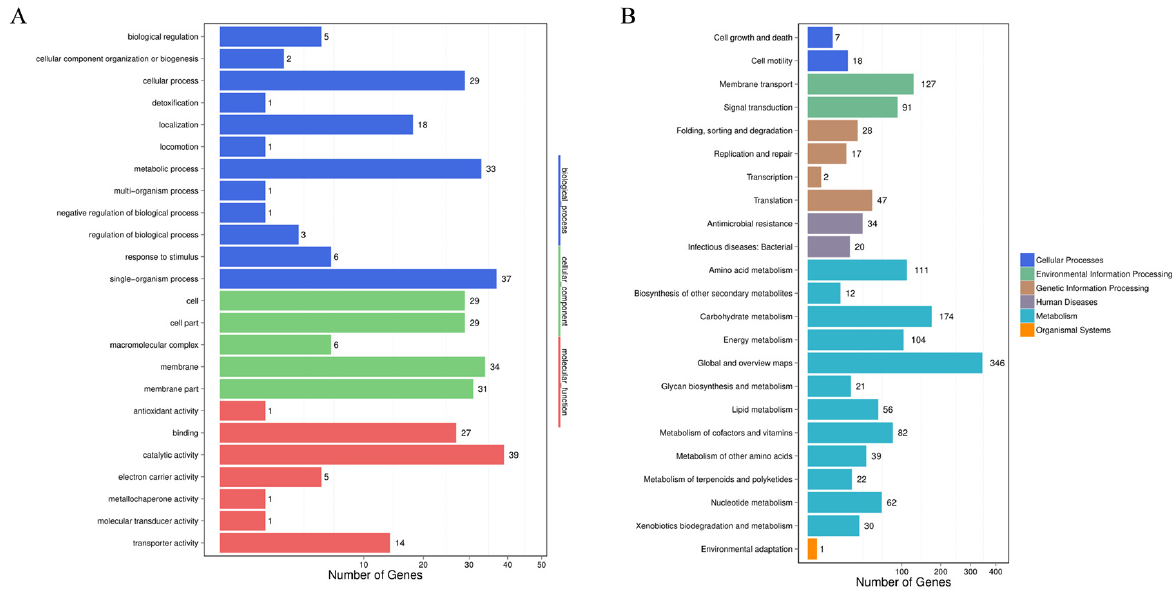
Figure 3. Differential genes analysis. ( A ) Analysis of significant enrichment in GO function of differential genes. The differentially expressed genes directly reflected the number and distribution of differentially expressed genes by GO term enriched. The abscissa is the number of differential genes, and the ordinate is GO terms. There are three categories of GO terms (biological progress, cellular component, and molecular function), which are marked with different colors. ( B ) Analysis of the pathway’s significant enrichment of differential genes. The differentially expressed genes directly reflected the number and distribution of differentially expressed genes through the KEGG public database. The abscissa is the number of differential genes, and the ordinate is the secondary KEGG pathway. The secondary pathways belong to different primary pathways, and different colors are used to indicate the primary pathway category in the